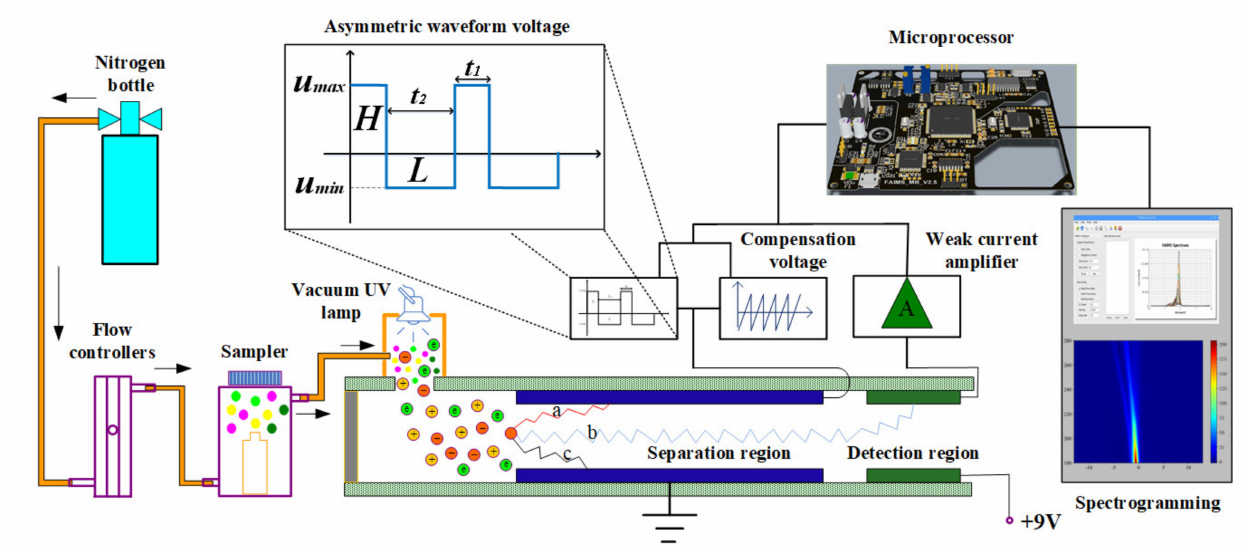
Figure 1. The homemade FAIMS experimental